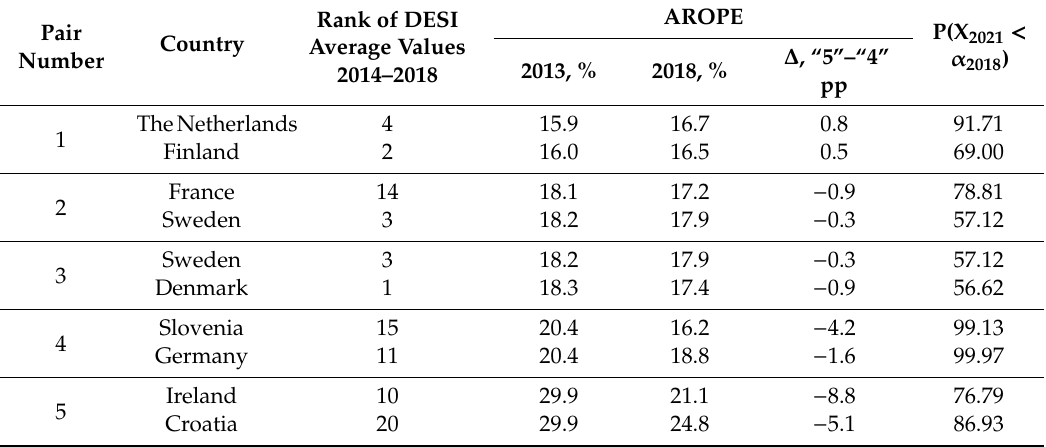
Table 10. The Dynamics of the Countries-Pairs with the Same (Close) Values of Percentage of the People at Risk of Poverty or Social Exclusion in 2013, Taking into Account the Average Digitalization